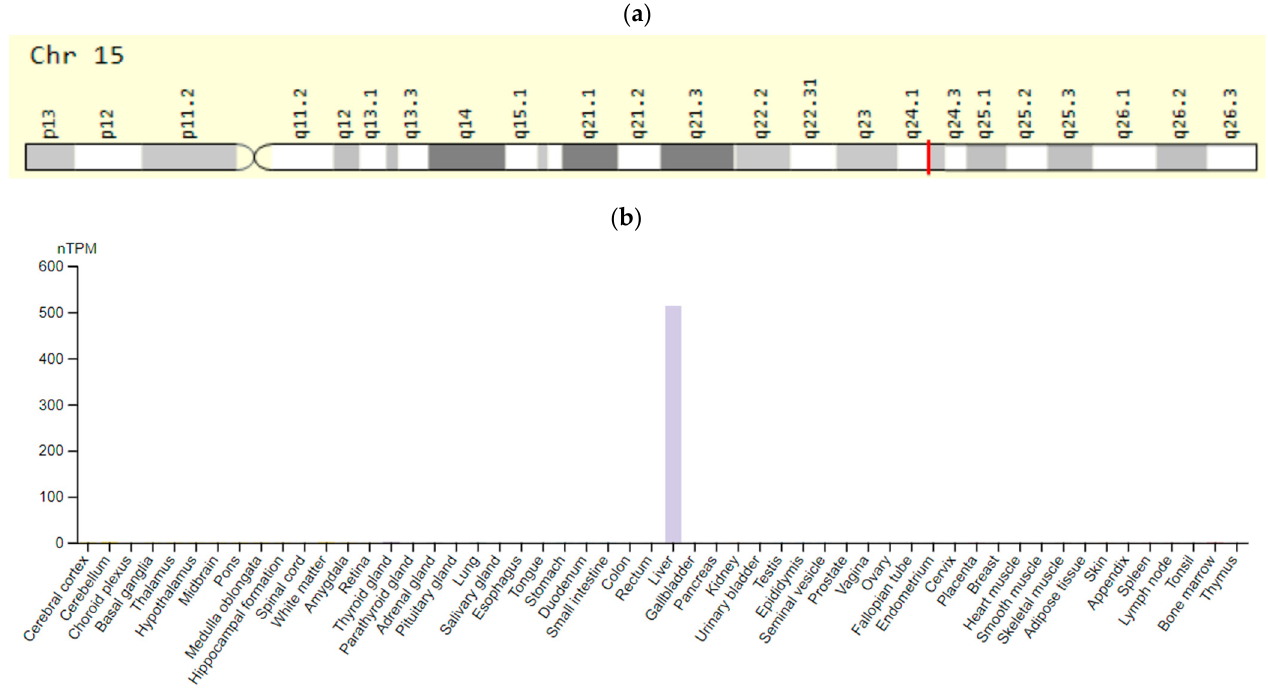
Figure 9. The CYP1A2 gene: ( a )–gene chromosome location; ( b )–protein expression in tissues of the human body [84,85].